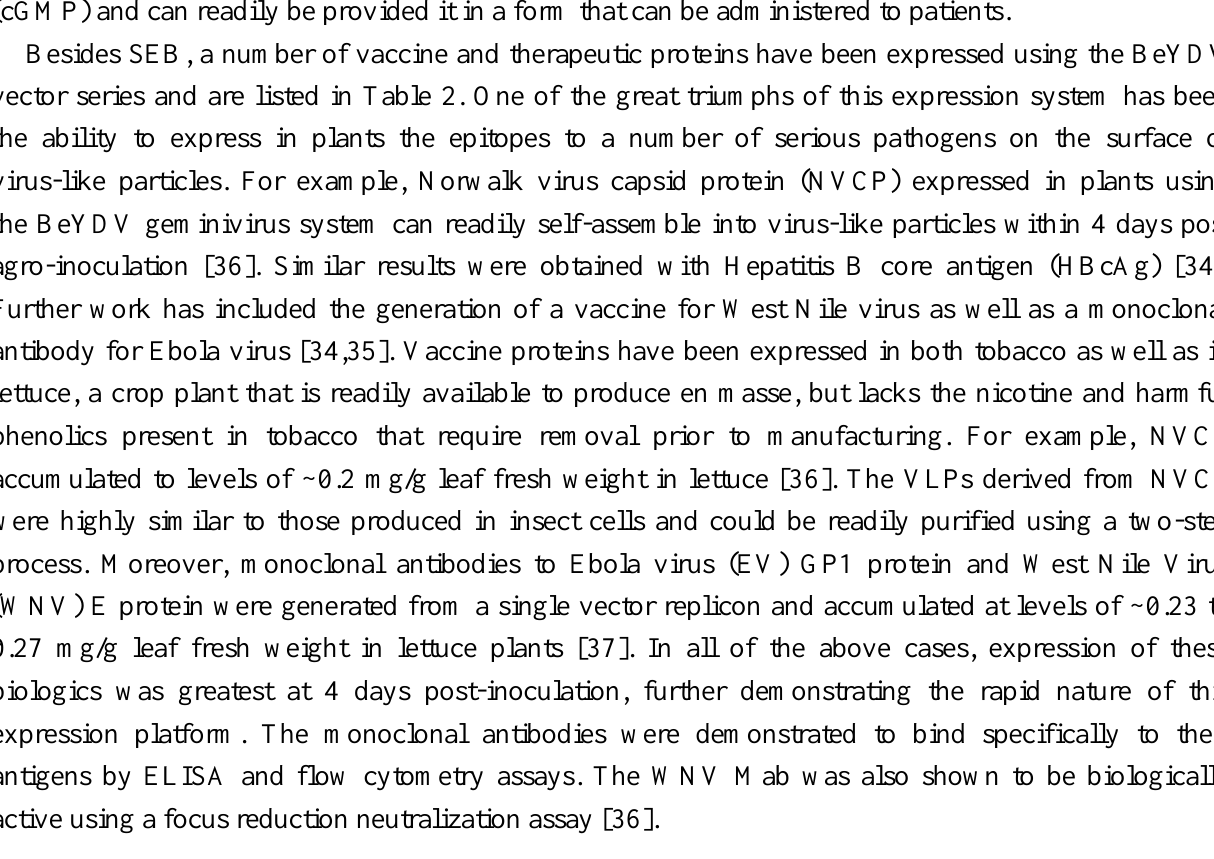
Table 2. Vaccines and other therapeutic proteins produced from geminivirus vectors. Therapeutic Protein Vector Used Host